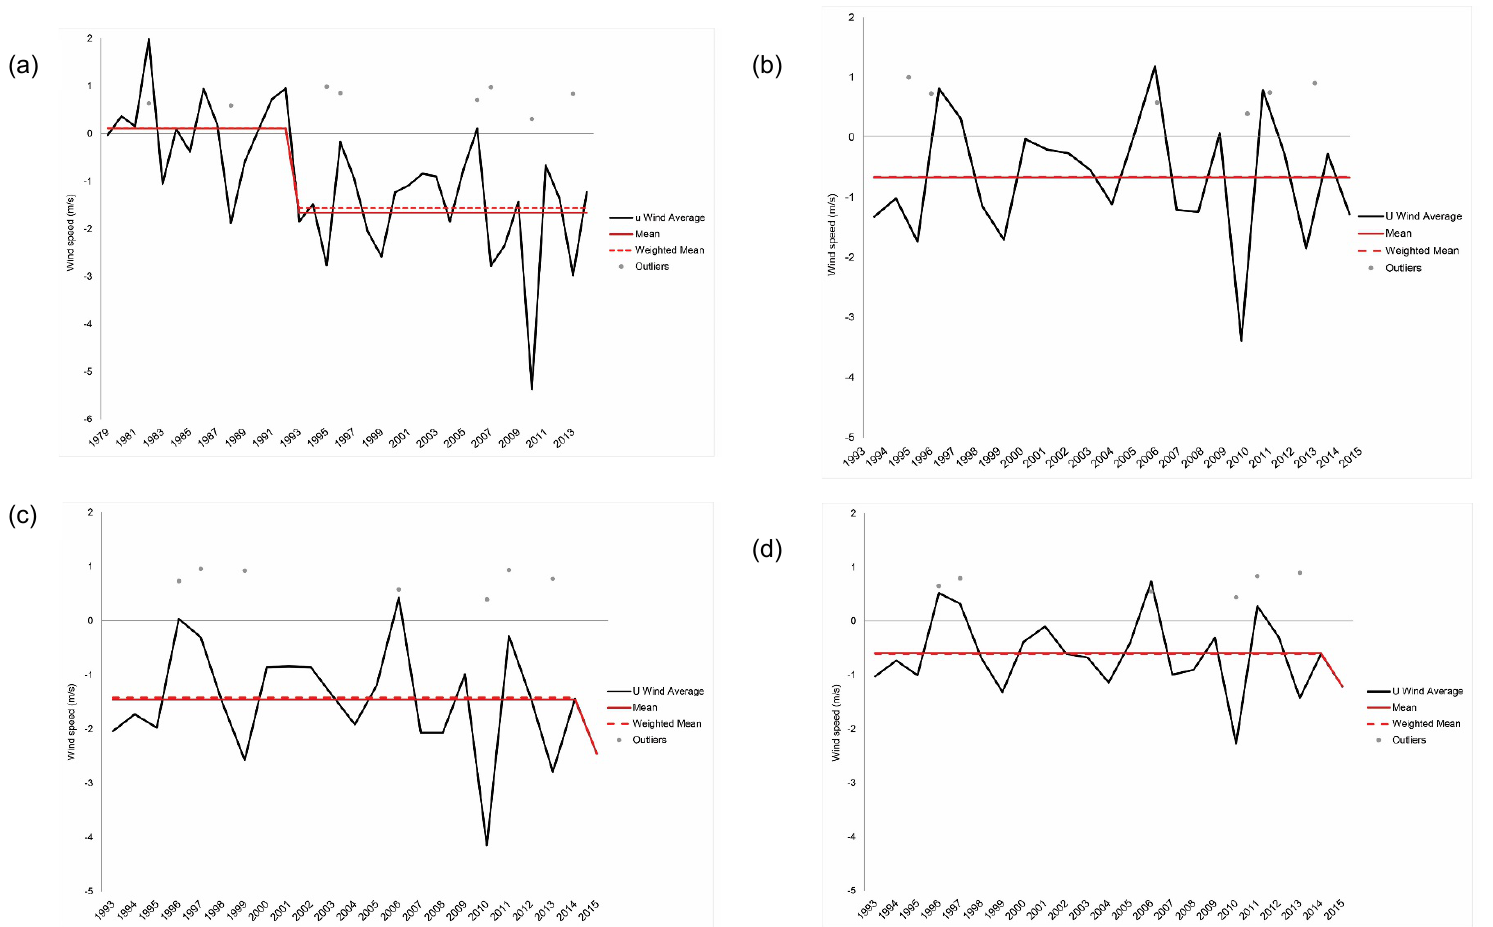
Figure A5.1: Summer mean values for U component of wind speed for (a) NCEP-DOE, (b) scatterometer aggregate, (c) Witsand and (d) Mossel